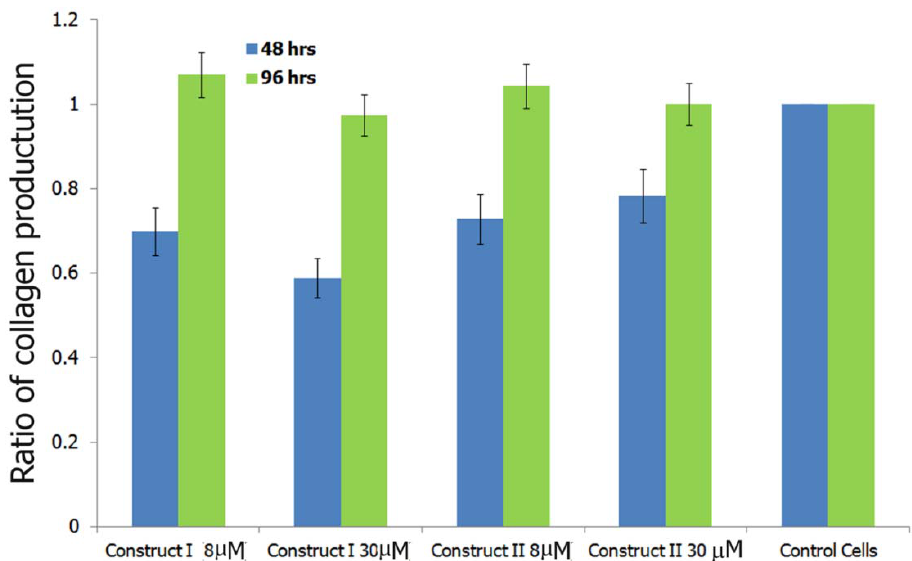
Figure 10. Ratio of soluble collagen synthesis compared to control cells, in the presence of constructs I and II over a period of 48 h and 96